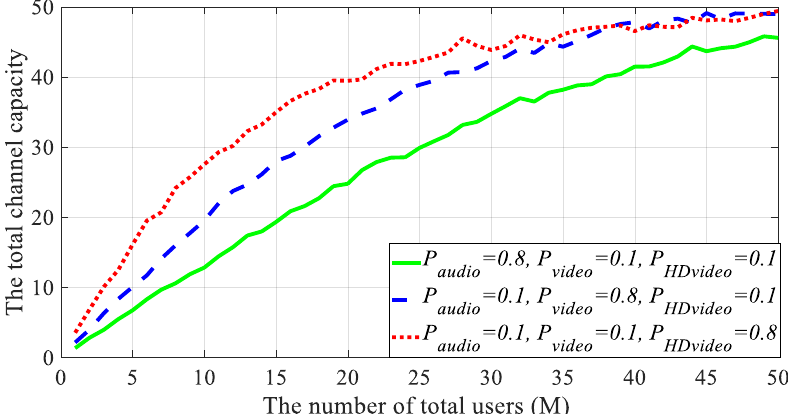
Figure 10. The total system channel capacity of the single relay-allowed modified pilot-based grouping method in scenario 1.